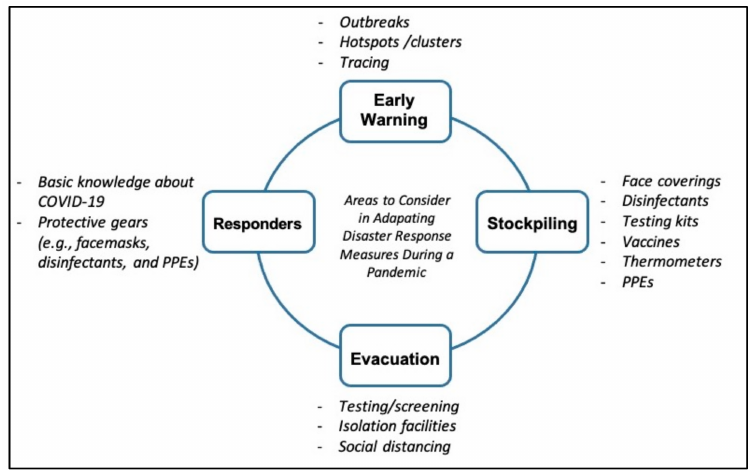
Figure 1. Adapting disaster response system with COVID-19